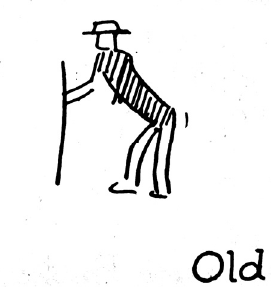
Figure 23. “Old Cloud” signature in Red Cloud’s census, Pine Ridge Agency, Dakota Territory, 1884 (Publ. in Mallery 1886, 1893). Figure 25. Picture-writing image informed by Old Cloud’s signature in Mallery (1886) (Publ. in Tomkins 1929).